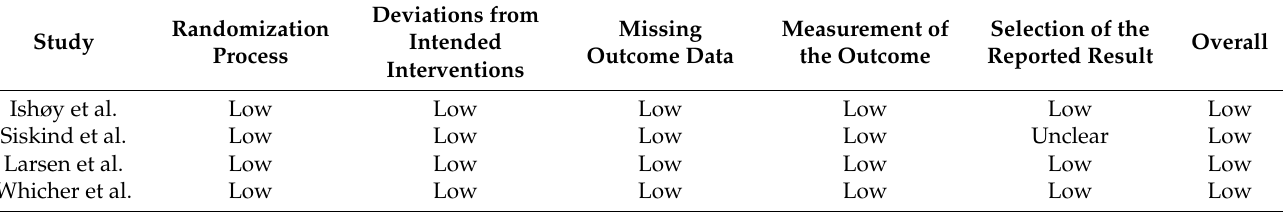
Table 2. Assessment of the risk of bias across the selected trials.